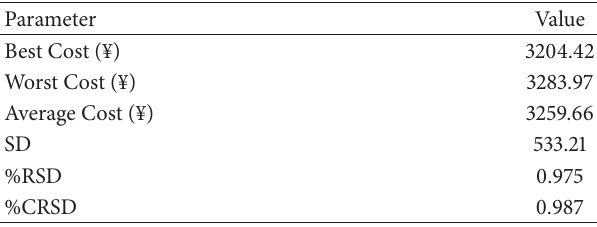
Table 5: Summary of different trials in VSS QGA.